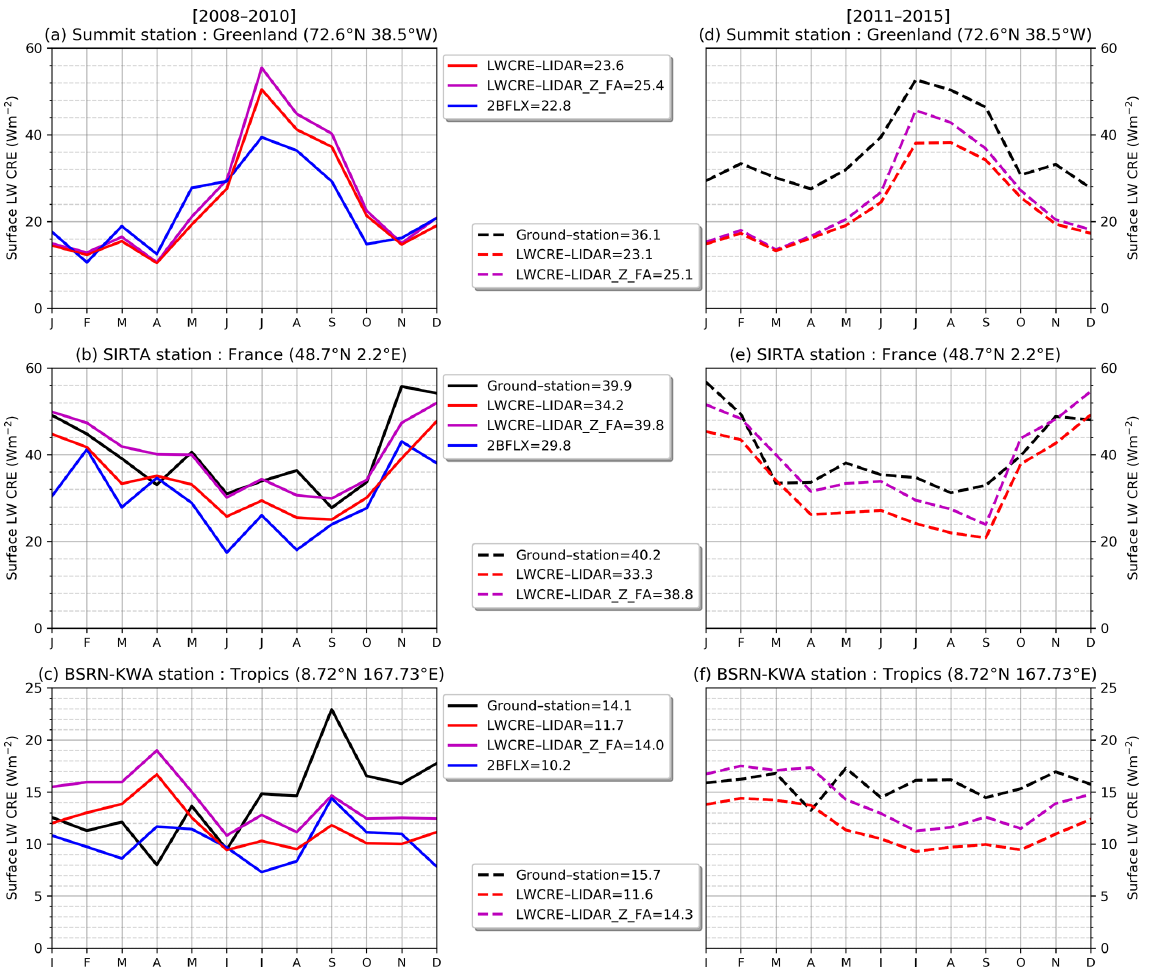
Figure 10. Same as Fig. 9 but in mean seasonal cycles. Panels (a) , (b) , and (c) correspond to 2008–2010 and panels (d) , (e) , and (f) correspond to 2011–2015. Note that the y -axis scale is different in each subplot.